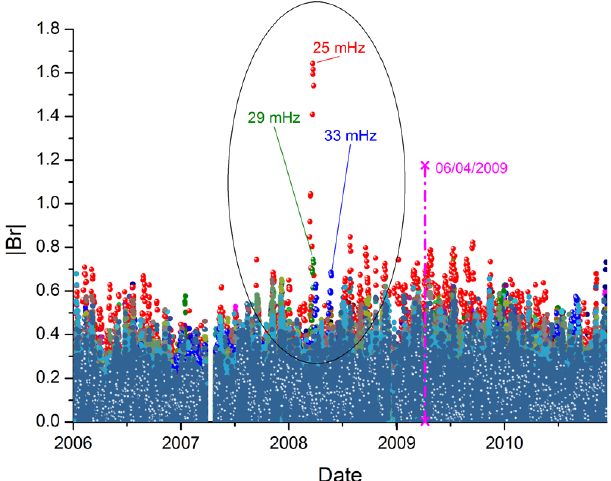
Fig. 2. The behaviour of the modulus of the real transfer functions B r for all harmonics with periods 0.5–5min (frequency range 3– 33mHz) in the wider time interval from 1 January 2006 to 31 De- cember 2010. The vertical line indicates the main shock onset. Around one year before the main shock, some harmonics (frequen- cies of 25, 29 and 33mHz: red, green and blue spheres, respectively) emerge from the background of 0.4